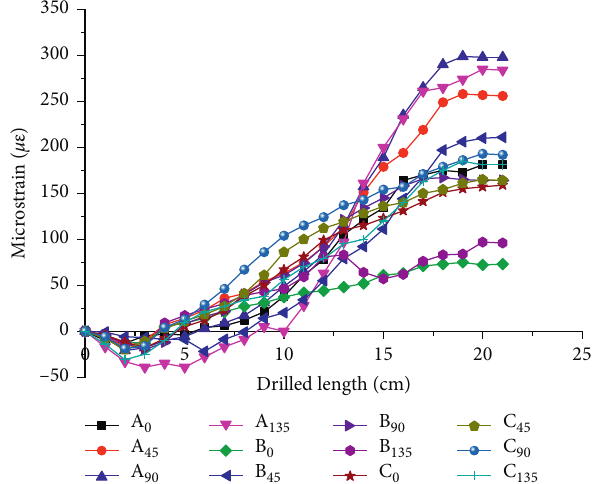
Figure 3: Typical measuring data curves of